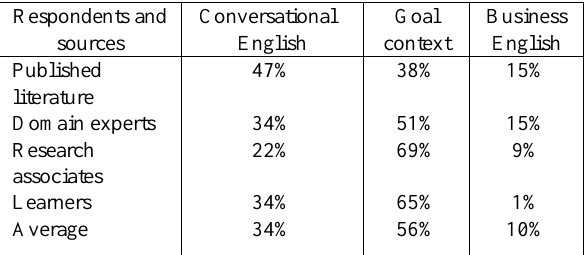
Table 1. The importance of the context in ESP